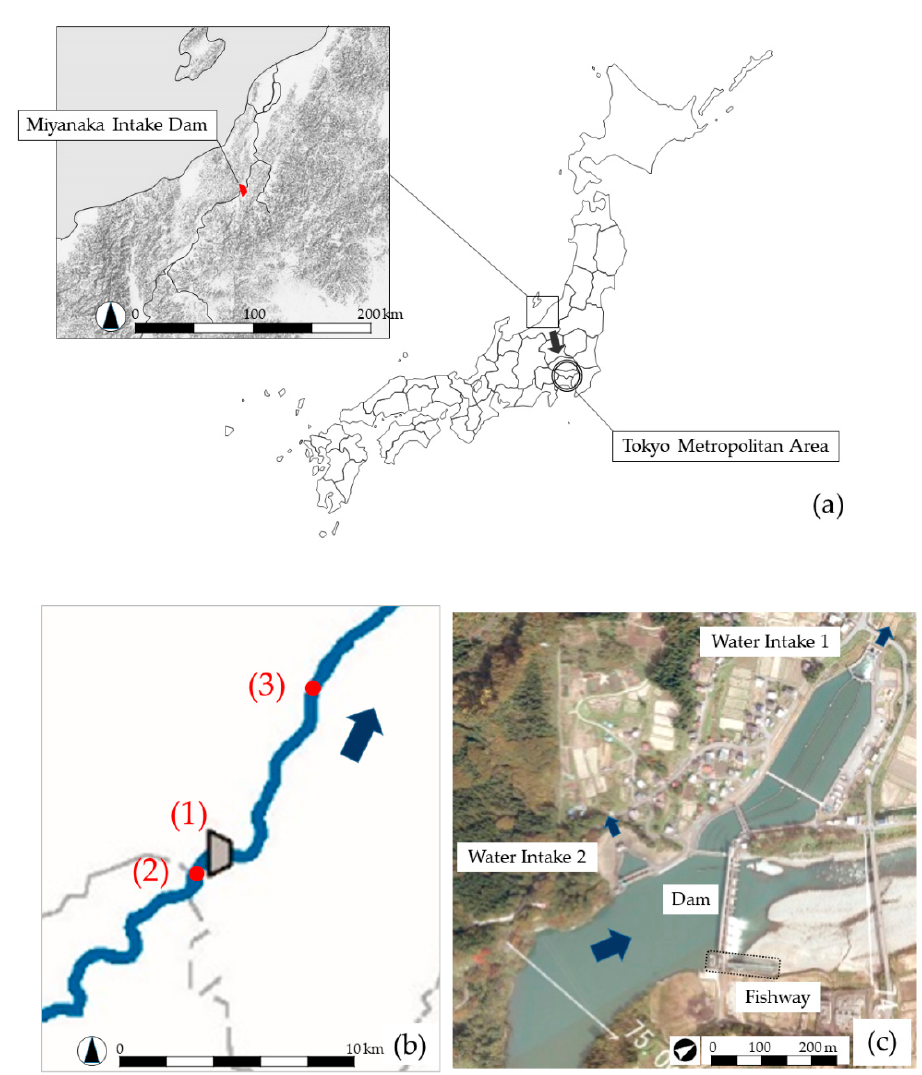
Figure 1. ( a ) Location of Miyanaka Intake Dam, Japan. ( b ) Three survey points utilized in this study: (1) Miyanaka Intake Dam fishway, (2) a point upstream from the dam (Himizo, Tokamachi City), and (3) a point downstream from the dam (Tokamachi Bridge). Because only the maintenance flow rate of 40 m 3 /s is discharged downstream from the dam, the river’s discharge rate and width are lower in (3) than (2). However, that has not changed since 2012. In addition, (2) was not affected as a flooded area because it was set further upstream of the flooded pond. ( c ) General overview of the fishway, which is located on the right-side bank of the dam, and water intake is located on the left-side bank. The maintenance flow rate (40 m 3 /s) is discharged from the gate on the right bank side, where the fishway is located, to exert the priming effect on the fishway. The maximum water intake is 166.96 m 3 /s for water intake 1 and 150 m 3 /s for water intake 2. Water is sent from the water intake to the power plant through a water tunnel.